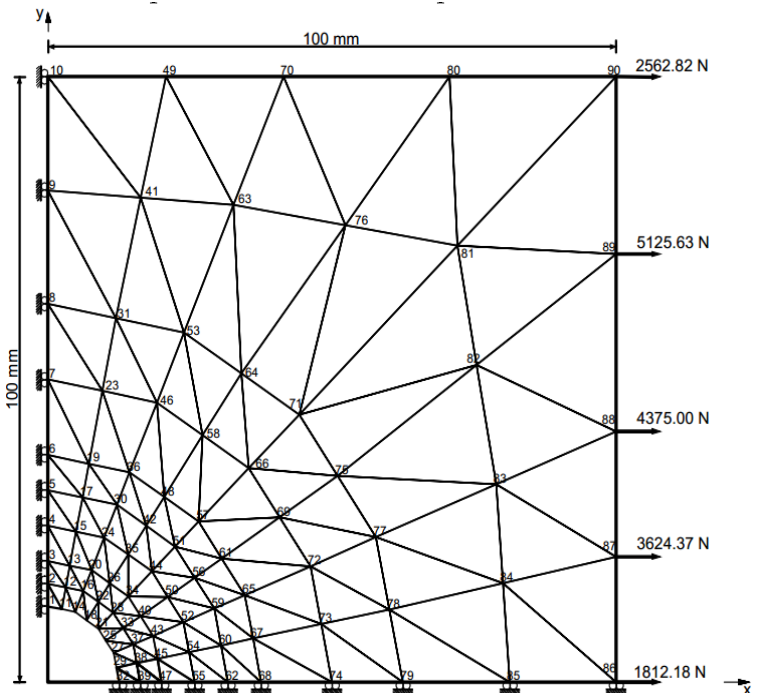
Figure 7. Structure 2: A plate with the hole in the middle.